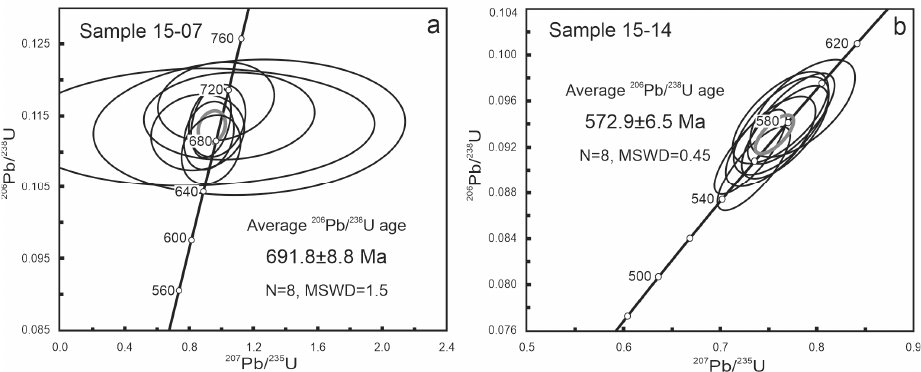
Figure 27. Concordia diagram for zircons from ( a ) metadacite (sample 15-07) and ( b ) amygdaloidal basalts (sample 15-14) of Kiselikha Group. Grey lue ellipse – average age values.